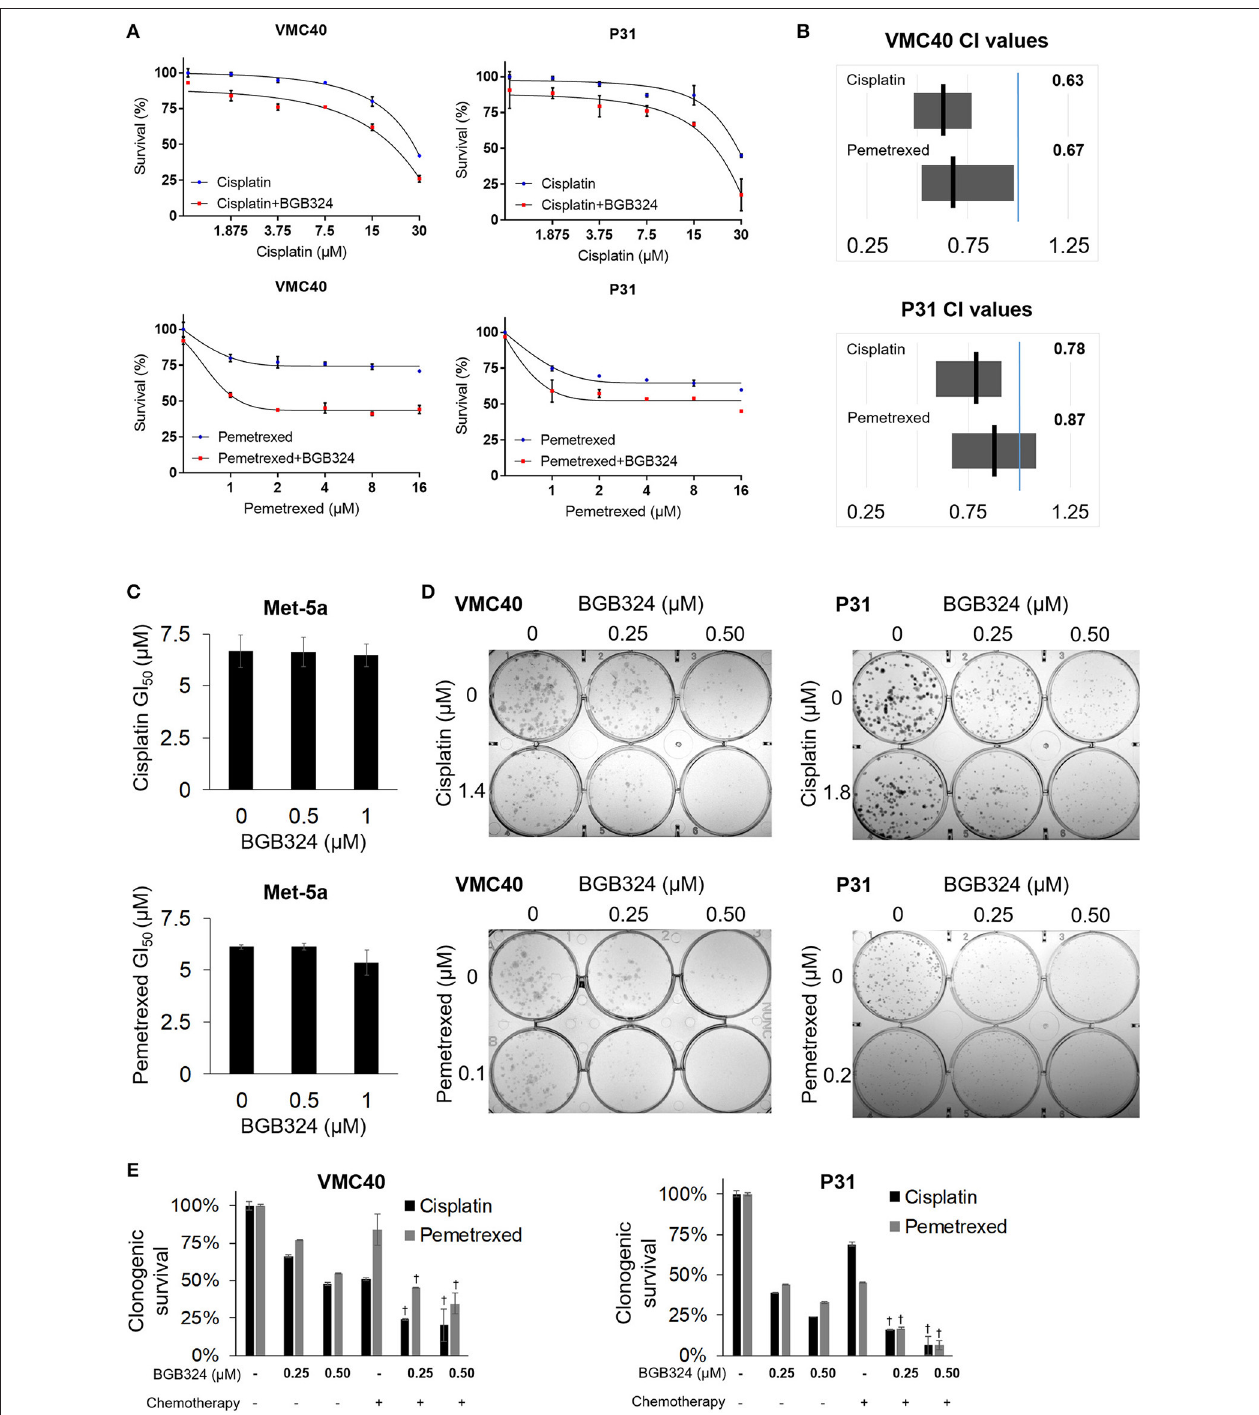
FIGURE 6 | Time-sequenced BGB324 combination with cisplatin and pemetrexed enhances MPM cell death. BGB324 was added 4h before other drugs. (A) Cell survival for incrementing concentrations of cisplatin and pemetrexed with and without 0.5 µ M BGB324. Values determined by SRB assay at 72h. Actual values, incrementing concentrations of BGB324, and statistical analysis at specified concentrations are shown in Supplementary Figure 8. (B) CI range (gray box) and mean (black line) from full data shown in Supplementary Figure 8A. The reference value, 1.00, is indicated by a blue line. CI < 1.00 is considered synergistic. CI values calculated as described in section Materials and Methods. (C) GI 50 values for cisplatin and pemetrexed in nonmalignant Met-5a cells. (D) Representative images of clonogenic assays after 72h treatment and then allowing cells to form colonies in absence of drugs. (E) Quantification of clonogenic assays. † Denotes p < 0.05 via t -test for value compared to values of single agents. Error bars represent ± SEM of three experiments (A,C,E) .